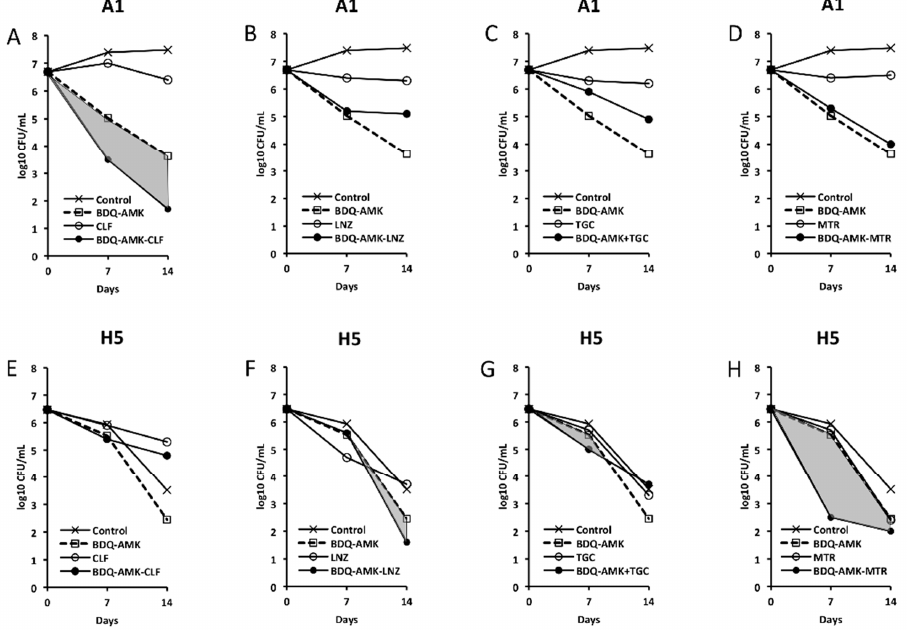
Figure 4. Activity against A1 and H5 cells of 3-drug combinations containing bedaquiline-amikacin (BDQ-AMK). ( A , E ) BDQ-AMK ± clofazimine (CLF); ( B , F ) BDQ-AMK ± linezolid (LNZ); ( C , G ) BDQ- AMK ± tigecycline (TGC); ( D , H ) BDQ-AMK ± metronidazole (MTR). Increases in the activities of (BDQ-AMK + third drug) versus BDQ-AMK are highlighted in